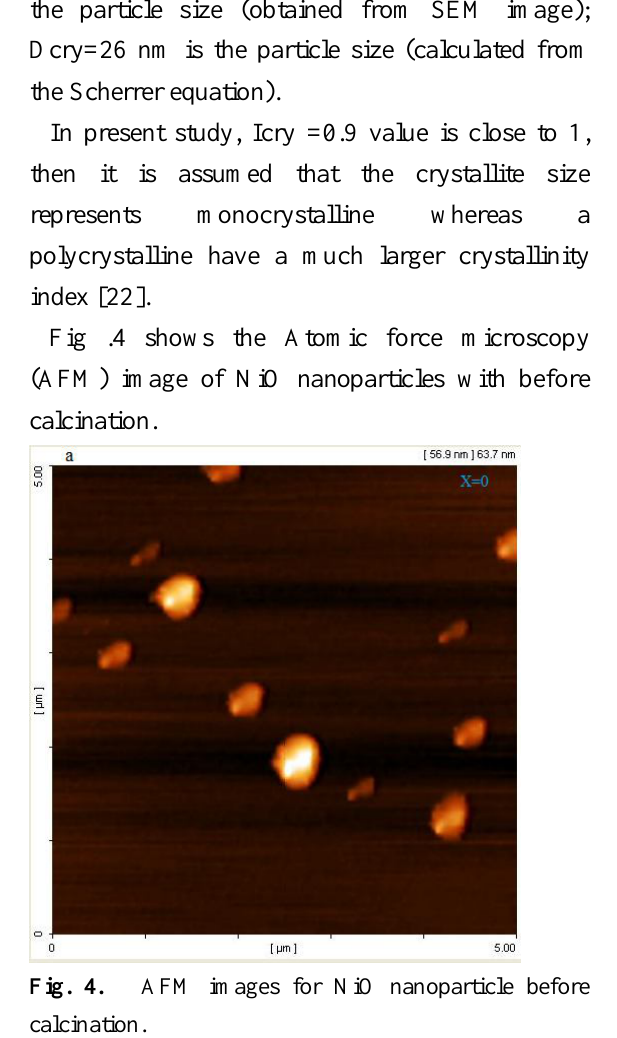
Fig.6. Magnetic hysteresis curves of NiO nanoparticle after calcinations. The values of the magnetic field [H] and listed in Table